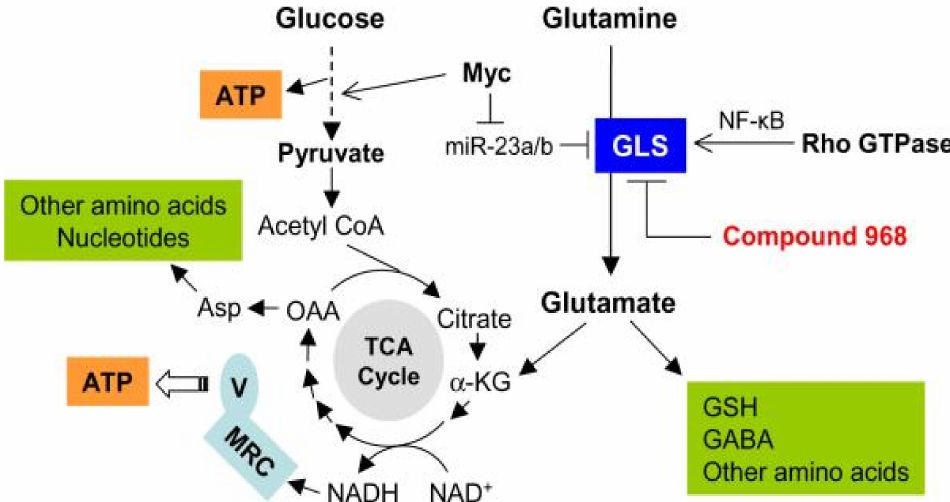
Figure 2. Regulation of glutamine metabolism in cancer cell through the modulation of glutaminase. As depicted in the figure, glucose and glutamine metabolism are interconnected. Assays performed with compound 968, an inhibitor of glutaminase, emphasized the importance of glutamine in the bio- chemistry of cancer cells. GLS: glutaminase; TCA cycle: tricarboxylic acid cycle; MRC: mitochondrial respiratory chain; V: mitochondrial respiratory complex V; OAA: oxaloacetate; Asp: aspartate; α -KG: α -ketoglutarate. Image reproduced from [26] with permission from Elsevier. Copyright © 2010.